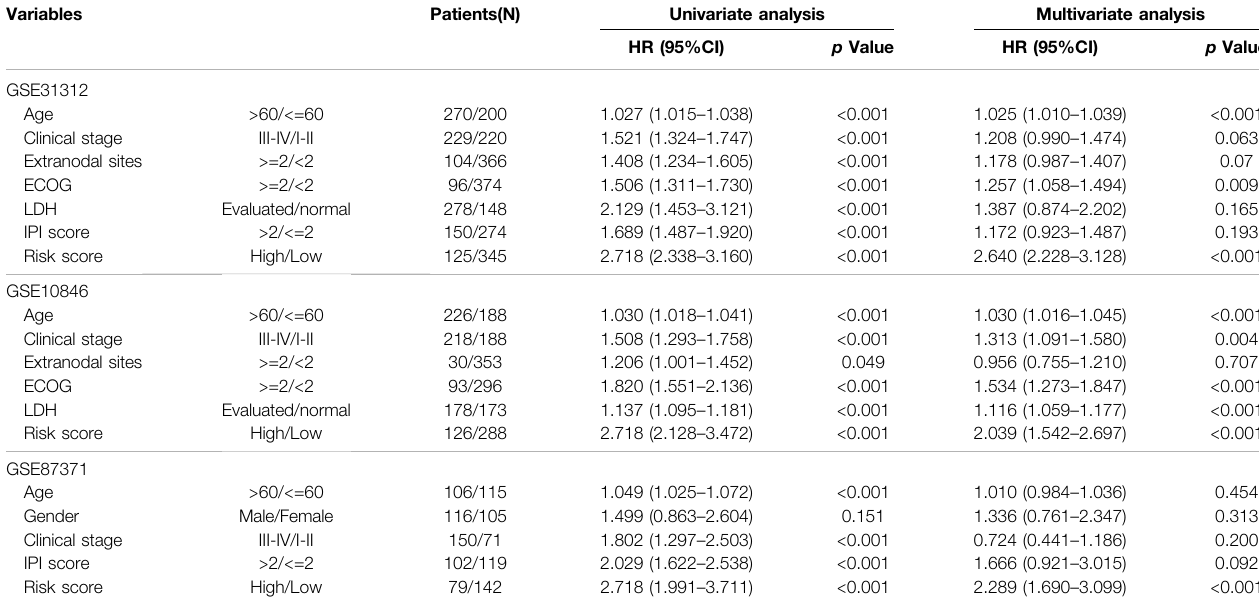
TABLE 1 | Univariate and multivariate Cox regression analyses of the gene signature and overall survival of DLBCL patients in 3 independent datasets.